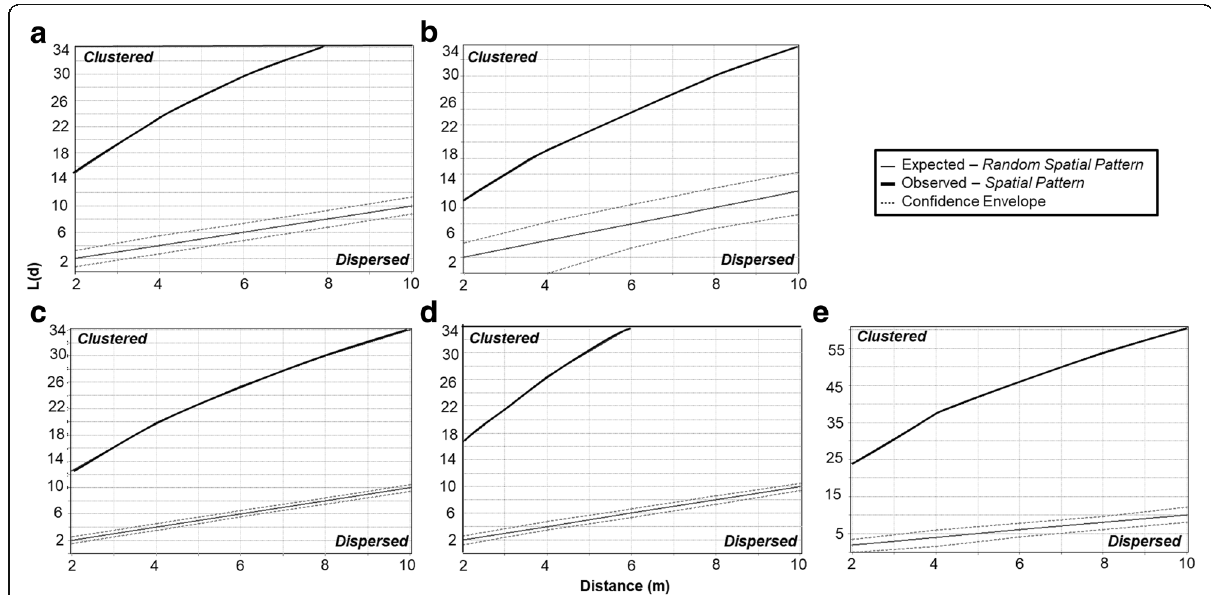
Fig. 6 Spatial distribution pattern of tropical ash for each distance class and vegetation type. a Distance class 300 m. b Distance class 600 m. c Tall forest. d Low forest. e